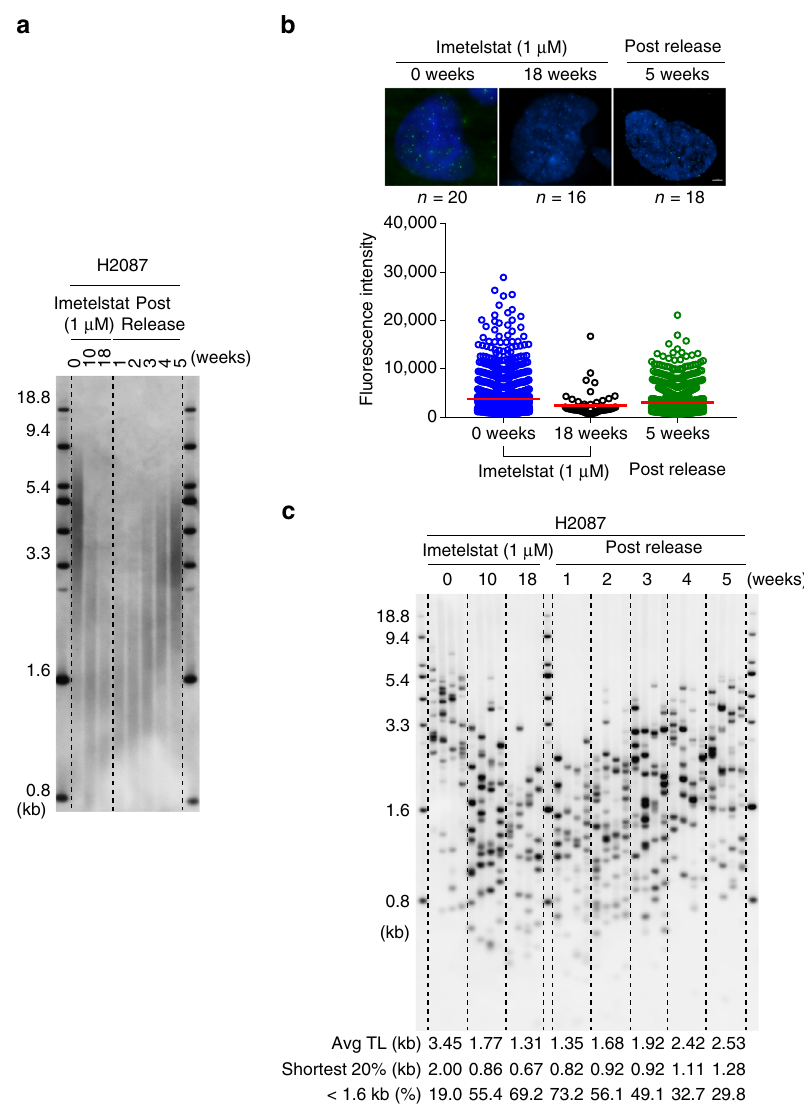
Fig. 2 Measuring TL in long-term telomerase inhibition with imetelstat (1 µ M) treatment and after the removal of drug in H2087 cells. a Isolated DNA from H2087 cells with 1 µ M imetelstat treatment for 0, 10, and 18 weeks, and post released from 18 weeks for 1, 2, 3, 4, and 5 weeks was digested with the same REs for TeSLA ( Bfa I/ Cvi AII/ Mse I/ Nde I) and then separated on 0.7% agarose gel for TRF analysis. b Interphase Q-FISH; cells from H2087 with 0 and 18 weeks 1 µ M imetelstat treatment, and 5 weeks after drug removal were used to measure TL by Q-FISH. The results were quanti fi ed using TFL-Telo software ( n : numbers of nuclei were quanti fi ed for each time point as indicated above). Scale bar, 3 µ m. c Results of TeSLA using DNA as indicated. Four TeSLA PCRs (30 pg of each reaction) were performed for each DNA